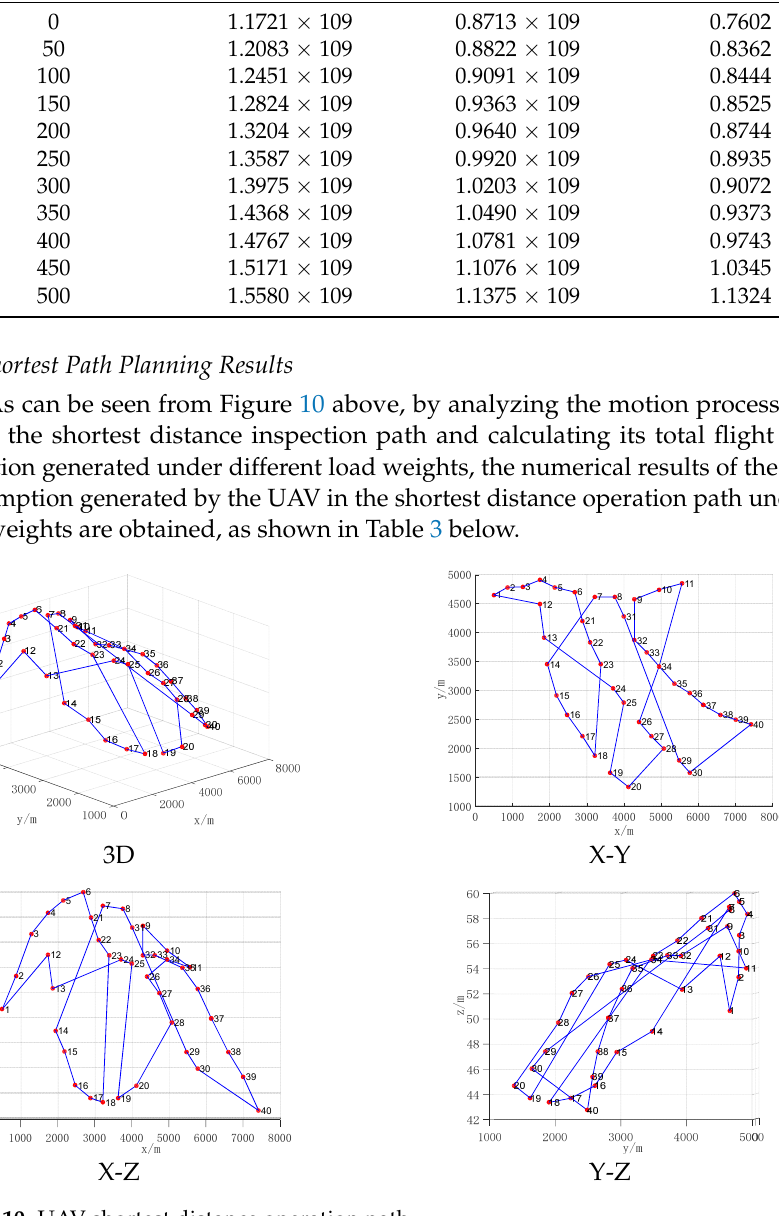
Figure 10. UAV shortest distance operation path.